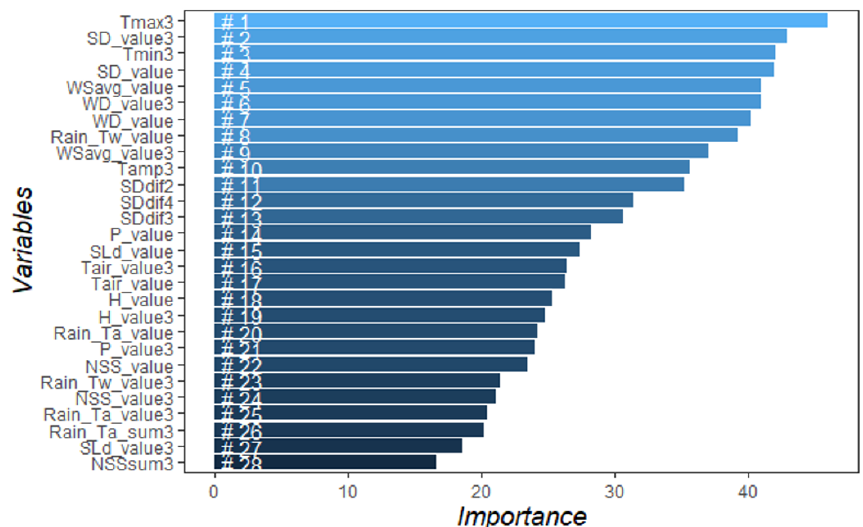
Figure 6. Variable importance using the mean decrease in accuracy (MDA) for each variable of the wet-avalanche dataset (winter seasons 1979–2020) in the random forests. Variables are described in Table